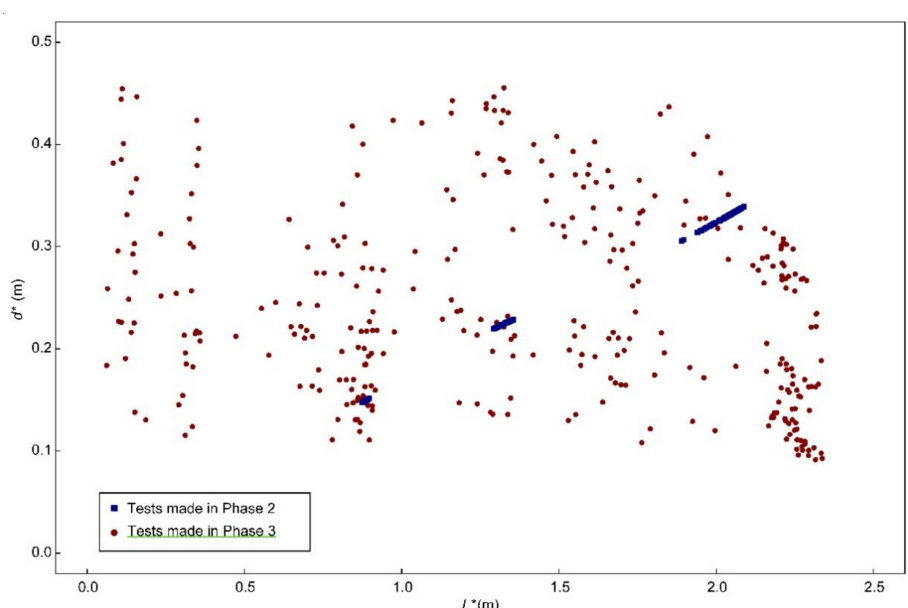
Figure 8. Combinations of d* (m) and L* (m) of the phase 2 tests conducted to formulate the energy dissipation criteria with only frontal flow, and the phase 3 tests that fulfilled such criteria with side jet